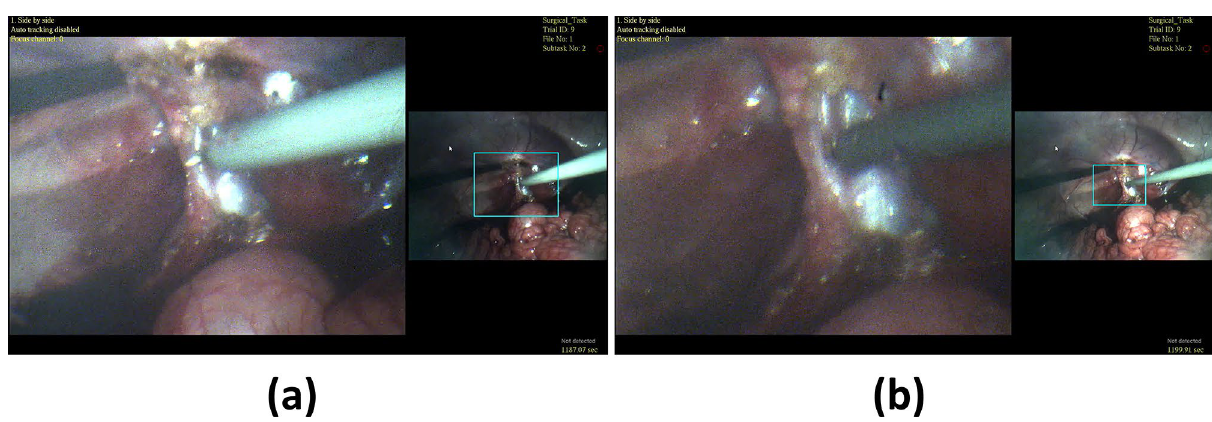
Figure 9. Images captured with the MRFL during porcine surgery. ETL autofocus ensures the zoomed-view image stays in focus through the full 2× ( a ) to 3× ( b ) zoom